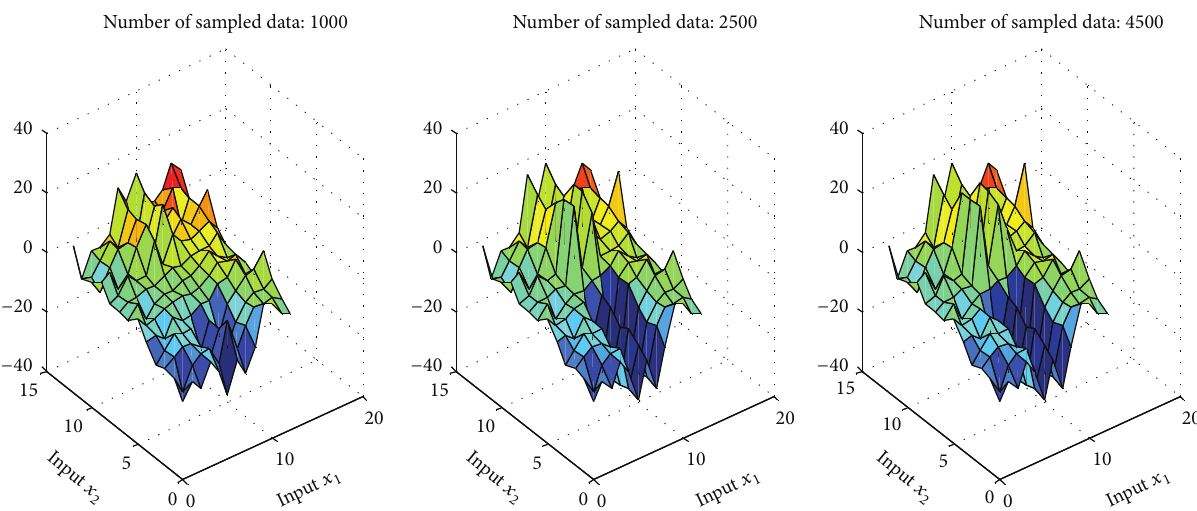
Figure 8: Training result of random set fuzzy surface.